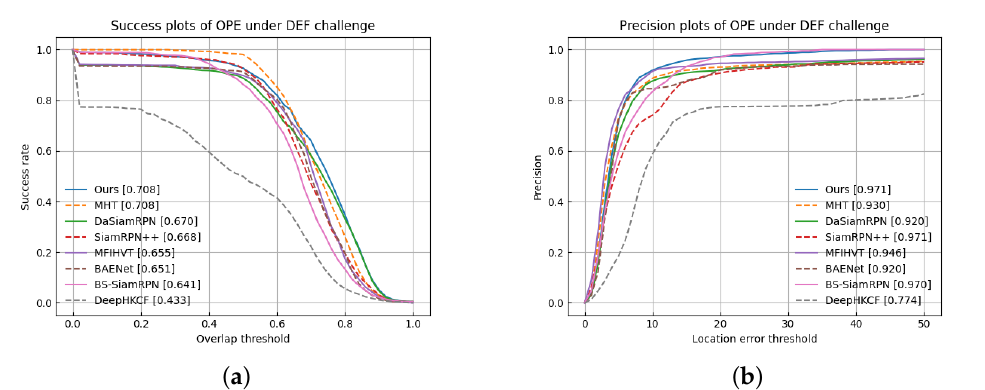
Figure 15. Comparison of performance curves in terms of deformation. ( a ) Success plots; ( b ) Precision plots.